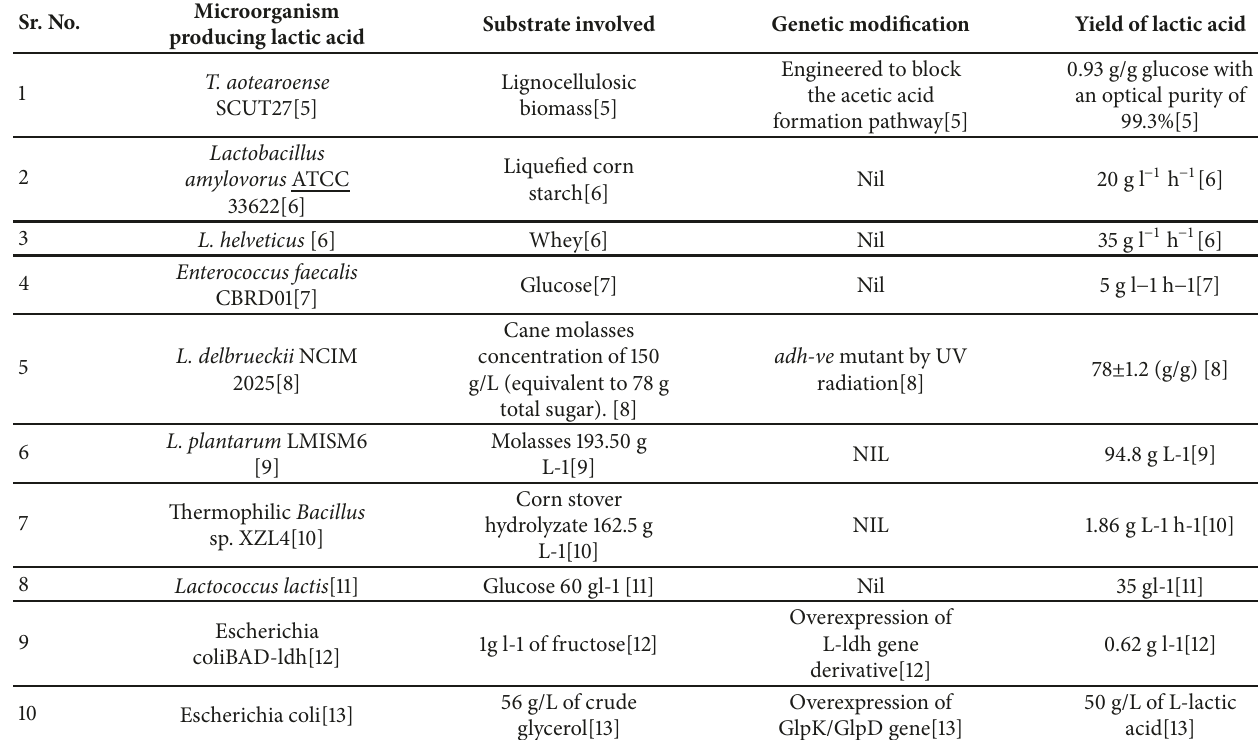
Table 1: Microorganism along with their yield of production of lactic acid by fermentation. S r .